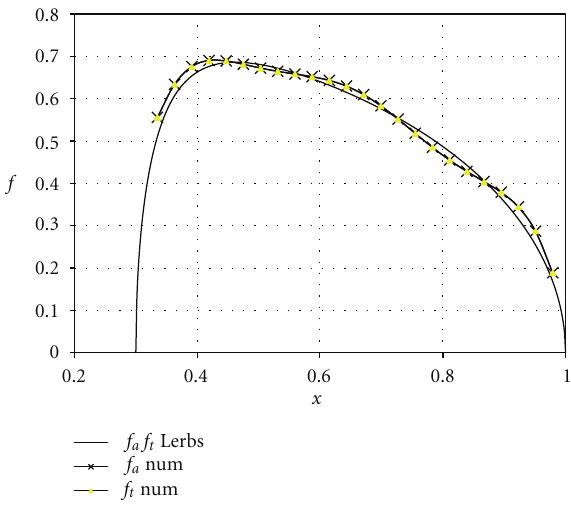
Figure 7: Comparison of the predicted average factor by the numerical method against Lerbs [2] analytical